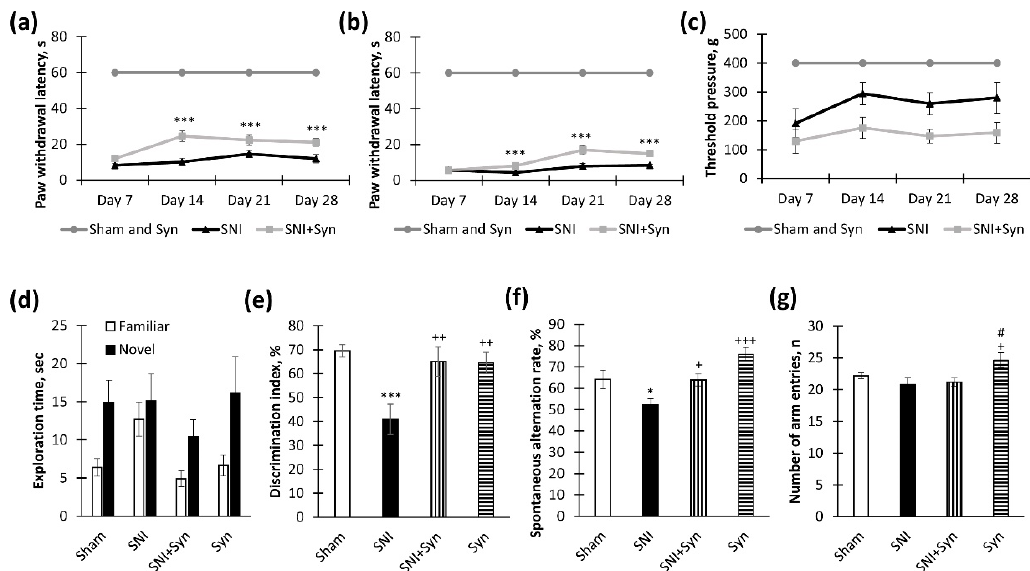
Figure 1. Effects of neuropathic pain and synaptamide therapy on behavior. ( a ) Hot allodynia dynamics: moment of hind paw lifting over hot plate (+48 °C) during 1-min observation, mean SEM, n = 20 (number of animals), *** p < 0.001. ( b ) Cold allodynia dynamics: the moment of hind paw lifting over the cold plate (+4 °C) during a 1-minute observation, mean ± standard error of the mean (SEM), n = 20 (number of animals), *** p < 0.001. ( c ) Mechanical hyperalgesia dynamics: the moment of toe flexor reaction following paw compression, mean SEM, n = 20 (number of animals),*** p < 0.001, ** p < 0.01, * p < 0.05 ( d ) Exploration time in novel objects recognition test, mean ± SEM, n = 20 (number of animals), * p < 0.05. ( e ) Discrimination index in novel object recognition test, mean ± SEM, n = 20 (number of animals), *** p < 0.001 (compared to “Sham”), ++ p < 0.01 (compared to “SNI”). ( f ) Spontaneous alternation rate in Y-maze, mean ± SEM, n = 20 (number of animals), * p < 0.05 (compared to “Sham”), + p < 0.05, +++ p < 0.001 (compared to “SNI”). ( g ) The number of the arm entries in the Y-maze, mean ± SEM, n = 20 (number of animals), + p < 0.05 (compared to “SNI”), # p < 0.05 (compared to “SNI + Syn”). SNI—spared nerve injury. Syn—synaptamide.